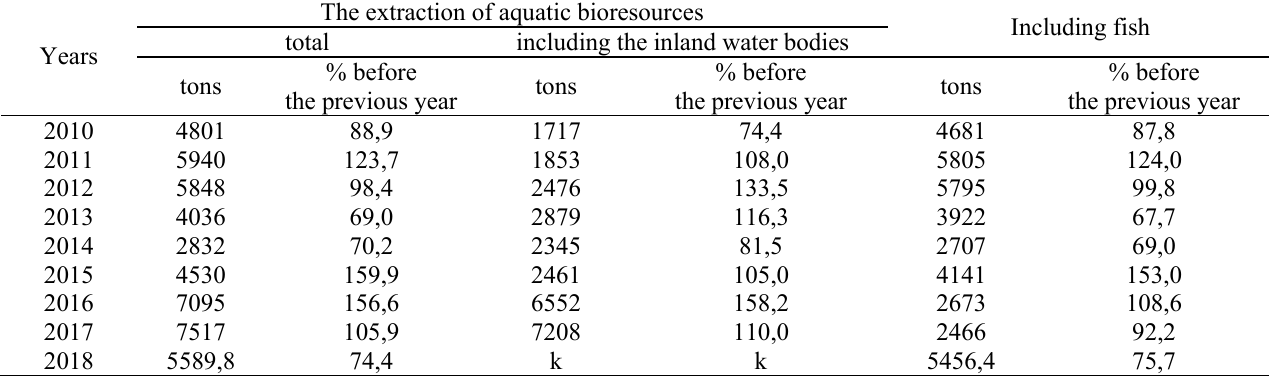
Catching the fish and extracting the aquatic bioresources of the Kherson region from 2010 to 2018 (according to the State Statistics Committee of Ukraine (Dobuvannia vodnykh bioresursiv za rehionamy))